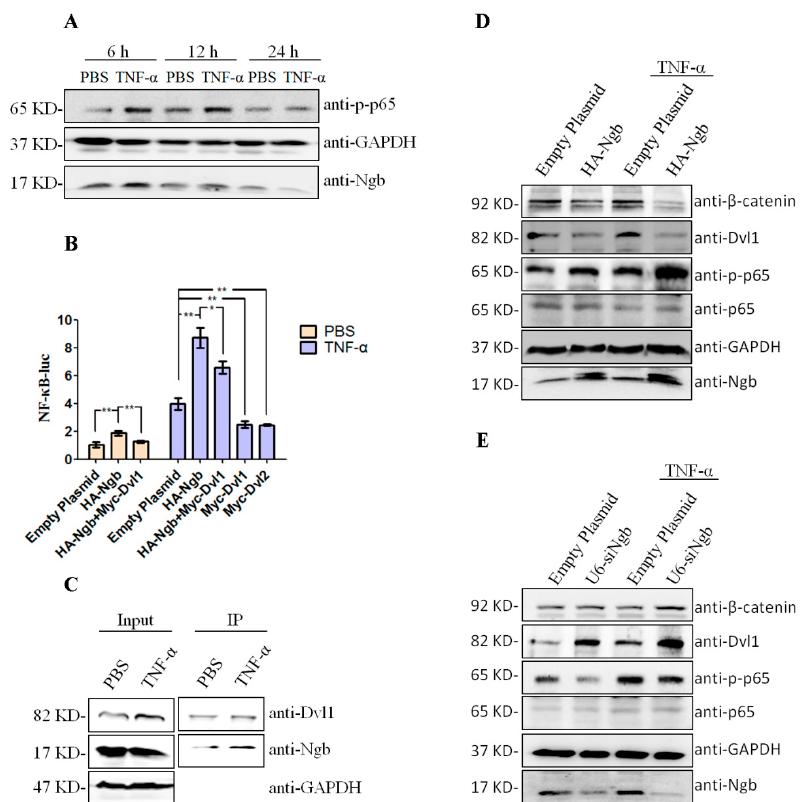
Figure 4. Ngb enhances TNF- α -induced-NF κ B activation via down-regulating Dvl1. ( A )